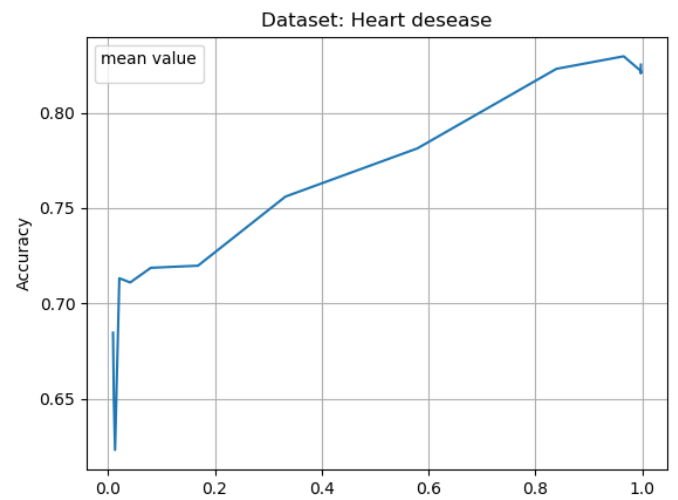
Figure 6. Mean result for 10 learning cycles, using 10 splits; for Heart disease data set; Mean result for 10 learning cycles, using 10 splits; for Australian credit data set; The only way to show the average values from the experiments was to calculate the average accuracy for specific granulation radii. Hence, on the x-axis we have the granulation radii (approximation levels). The figure shows the result from Table